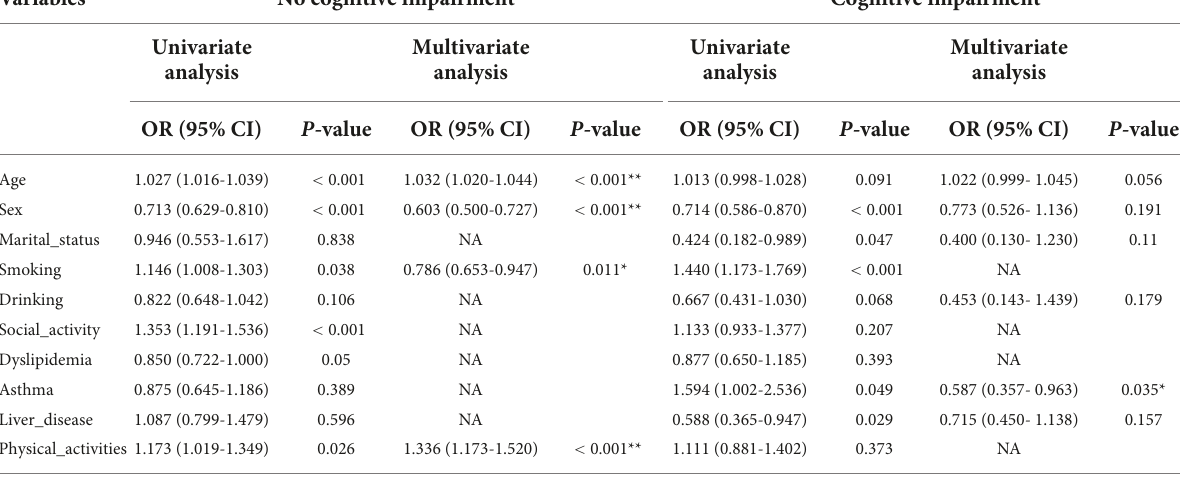
TABLE 1 Univariate and multivariable logistic regression analysis of patients with and without dentures. Variables